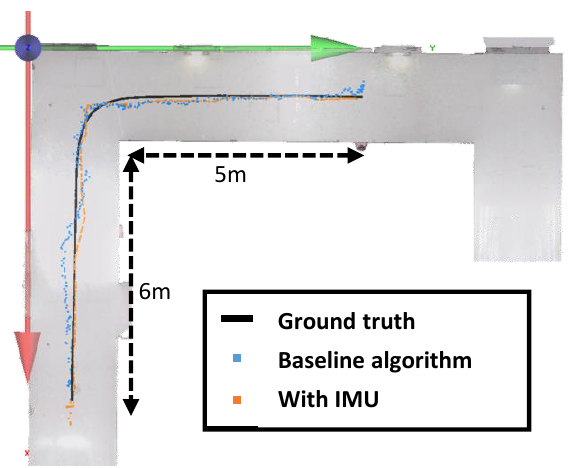
Figure 6. The traces of estimated camera positions with and without